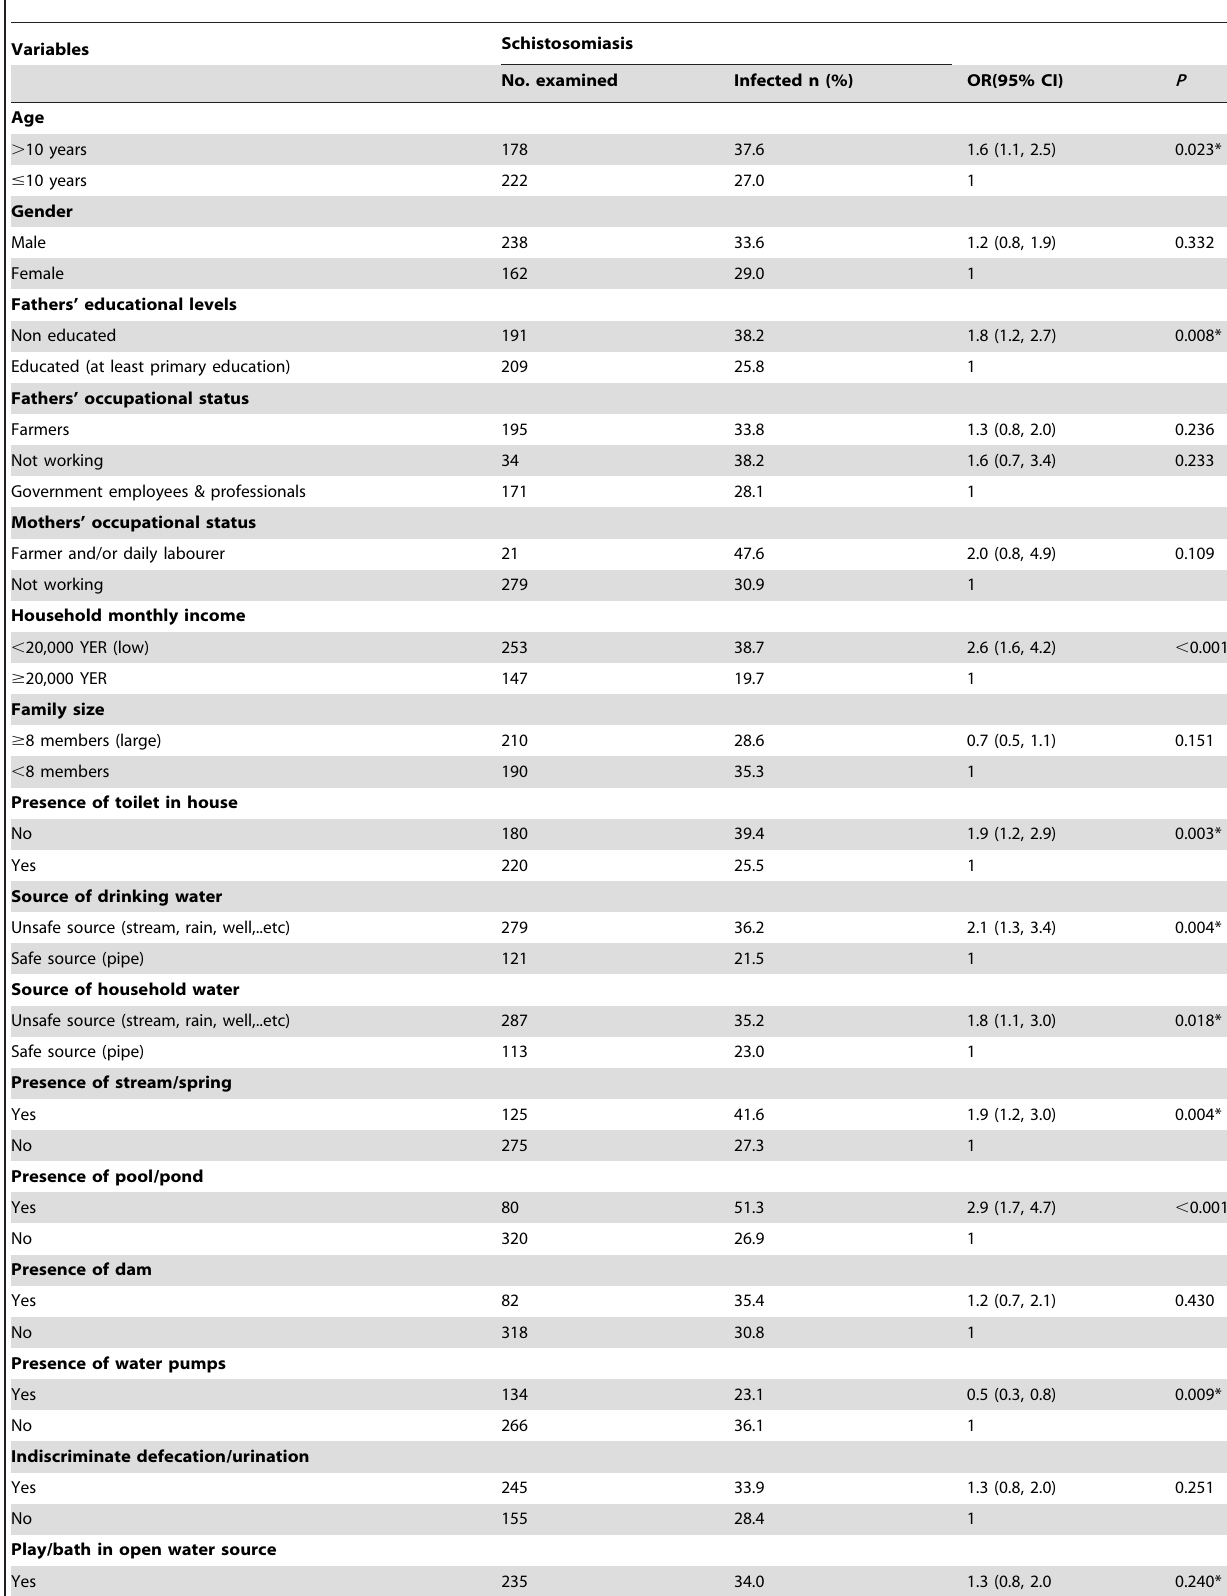
Table 3. Univariate analysis of factors associated with schistosomiasis among Yemeni children who participated in this study